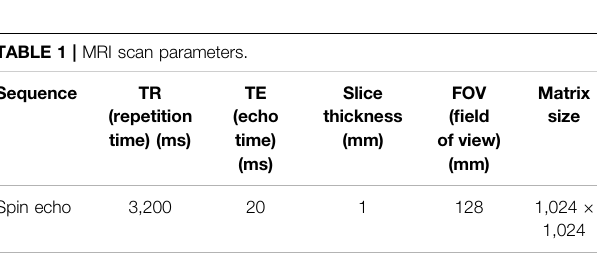
TABLE 1 | MRI scan